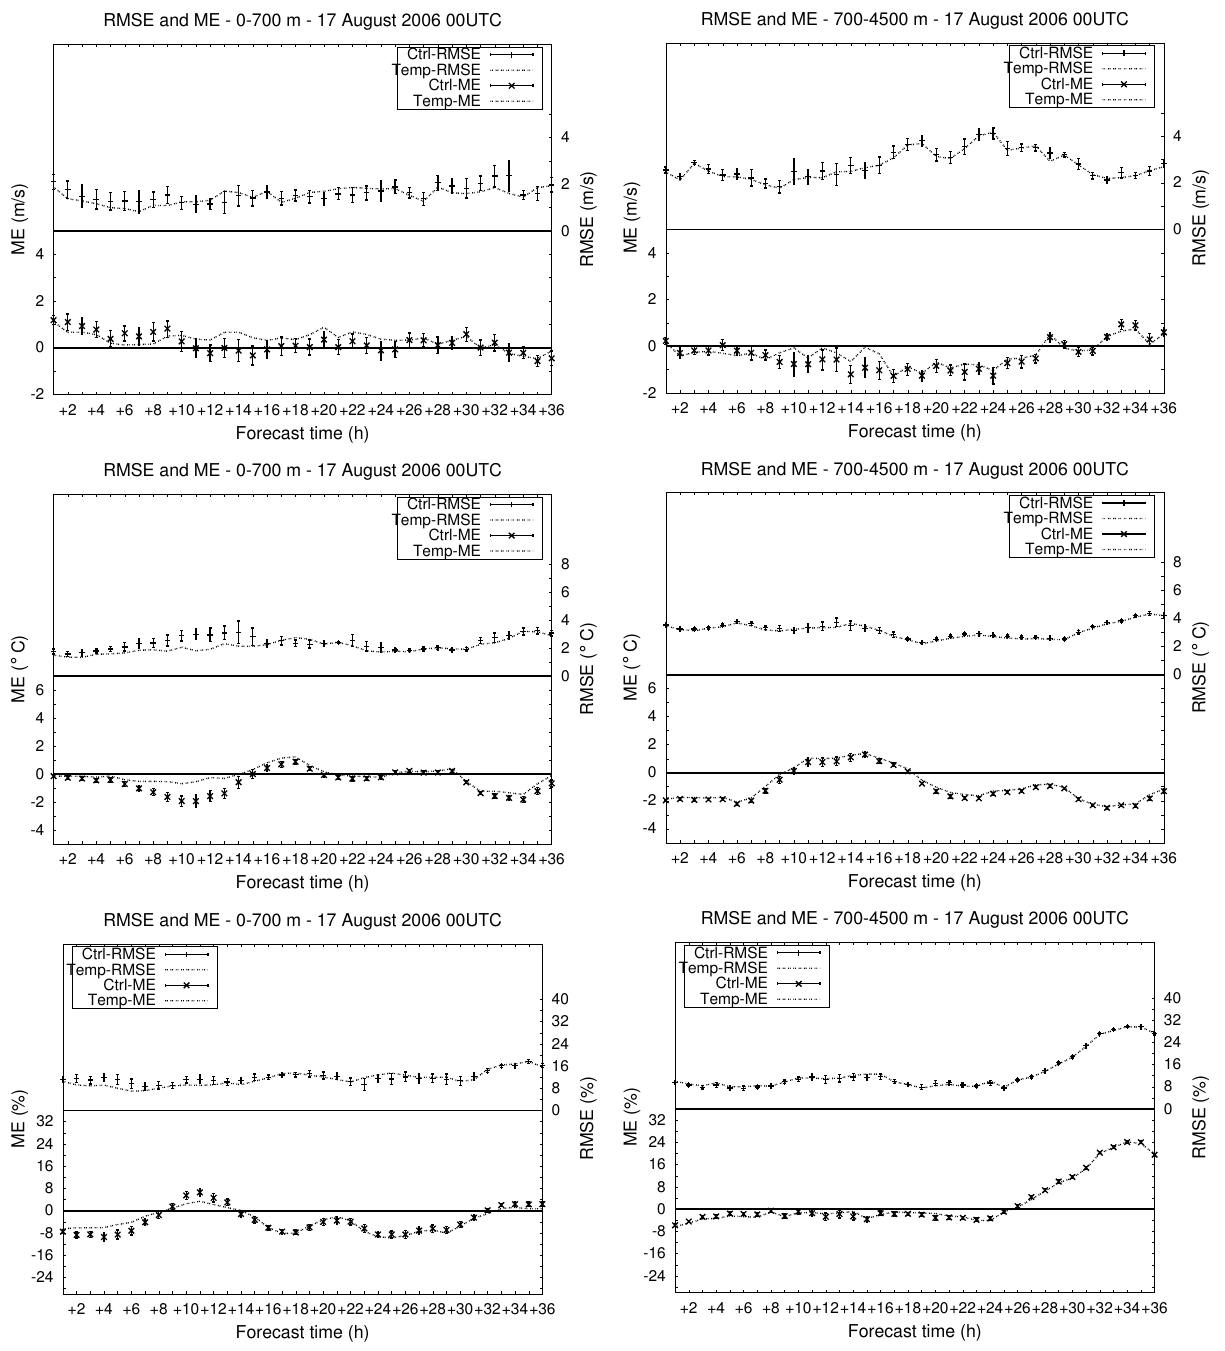
Fig. 5. RMSE and ME for the August 2006 case, over the plains (left) and over the mountains (right); wind intensity (upper panels), temperature (middle panels) and relative humidity (bottom panels). The dots represent the Ctrl run with the significance bar and the dotted line represents the Temp run.